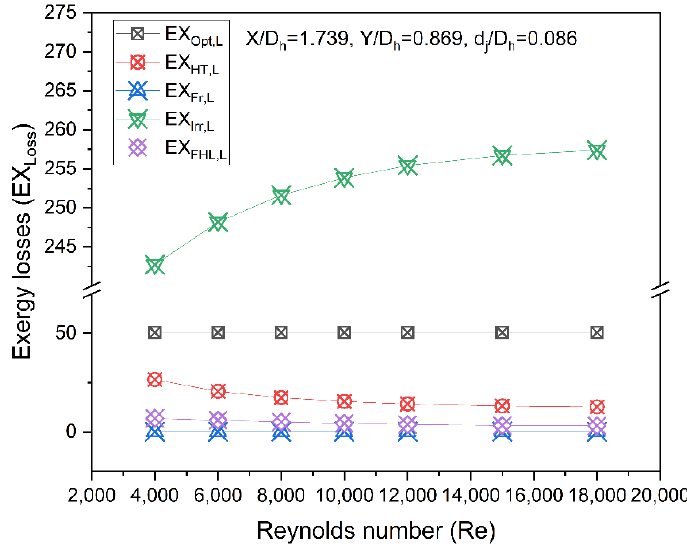
Figure 15. Various exergy losses encountered for varying Re values.